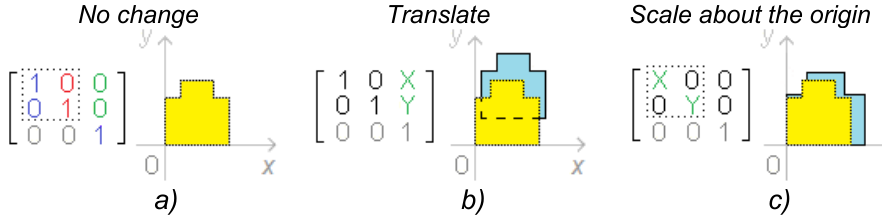
Figure 2 – Transformation matrices and the results of their impact on the chest target: a – unit matrix; b – translation; c – nonuniform